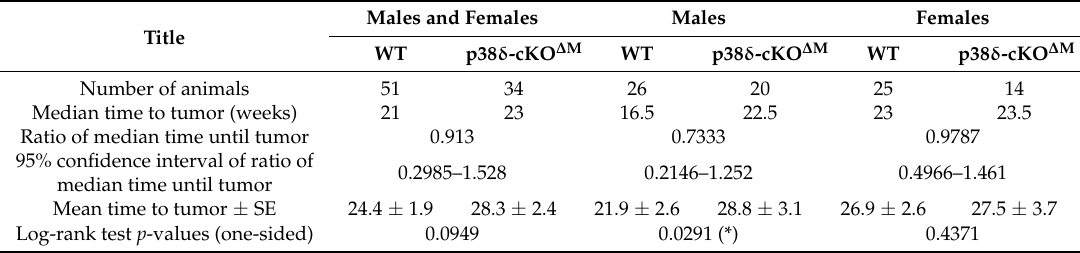
Table 1. Tumor latency (time to first tumor) was significantly delayed in male mice with